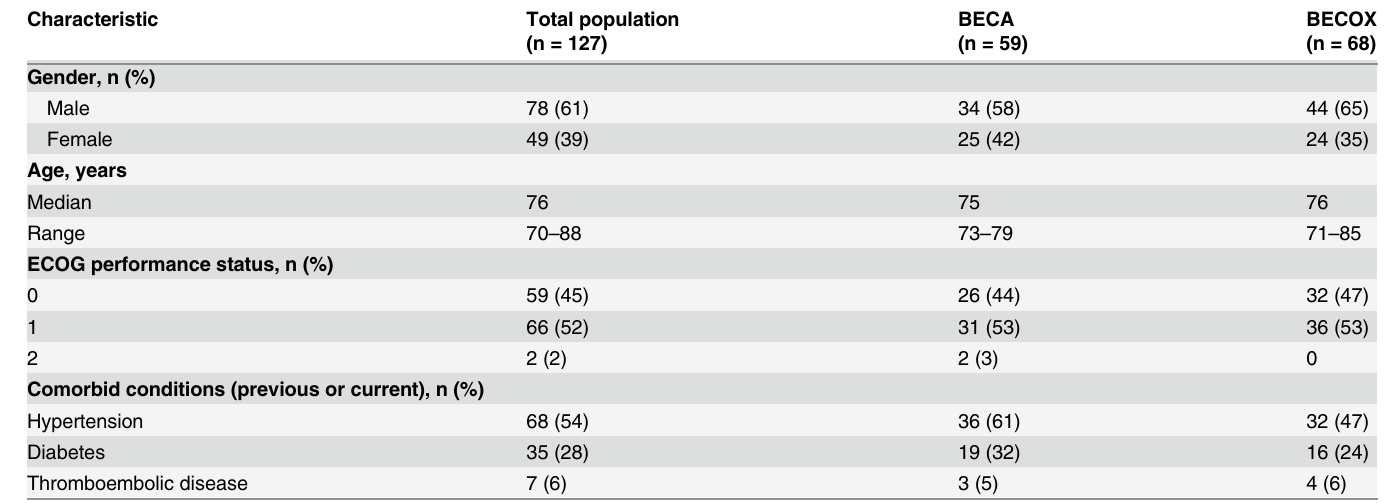
Table 1. Patient characteristics at